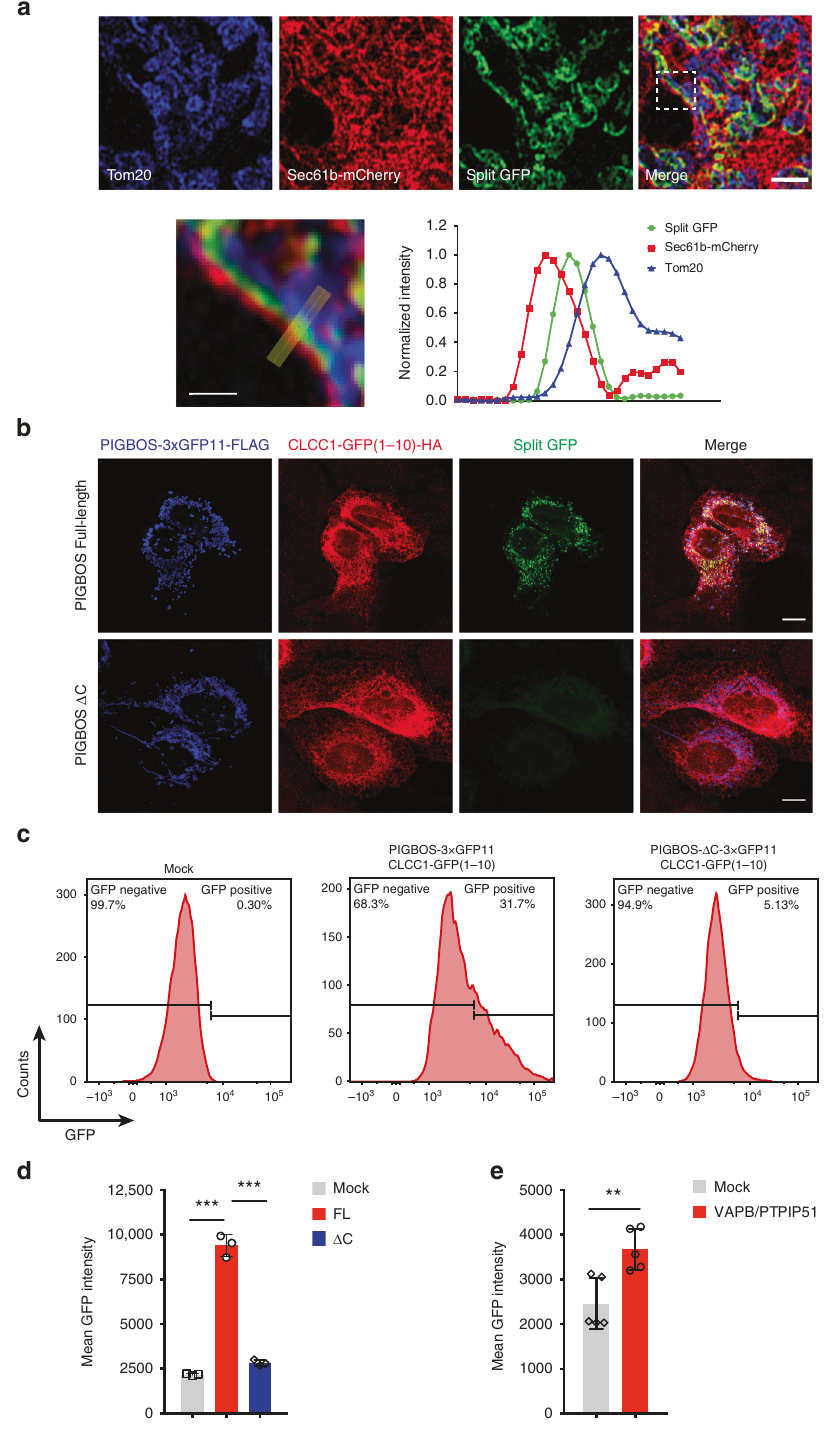
opposite effect, in which the UPR target genes showed less UPR activation, indicating a tunable modulation of ER stress by PIGBOS microprotein levels (Supplementary Fig. 14b). We then con fi rmed via Western blot that TM treatment of PIGBOS-KD cells led to higher ATF4 and CHOP protein levels (Supplemen- tary Fig. 13h). These data identi fi ed PIGBOS as a heretofore unknown mitochondrial regulator of UPR, and the only known microprotein linked to the regulation of cell stress or inter- organelle